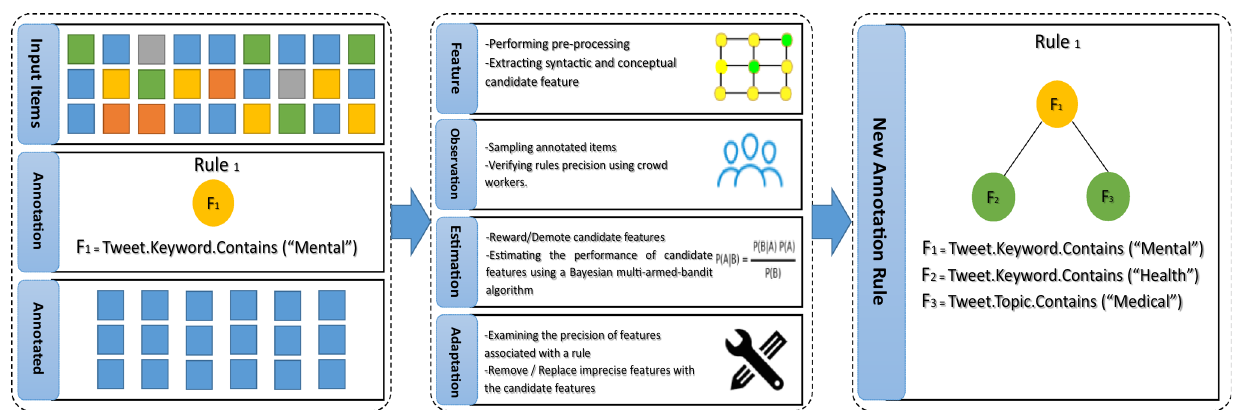
Fig. 2 The overview of the proposed approach for adapting